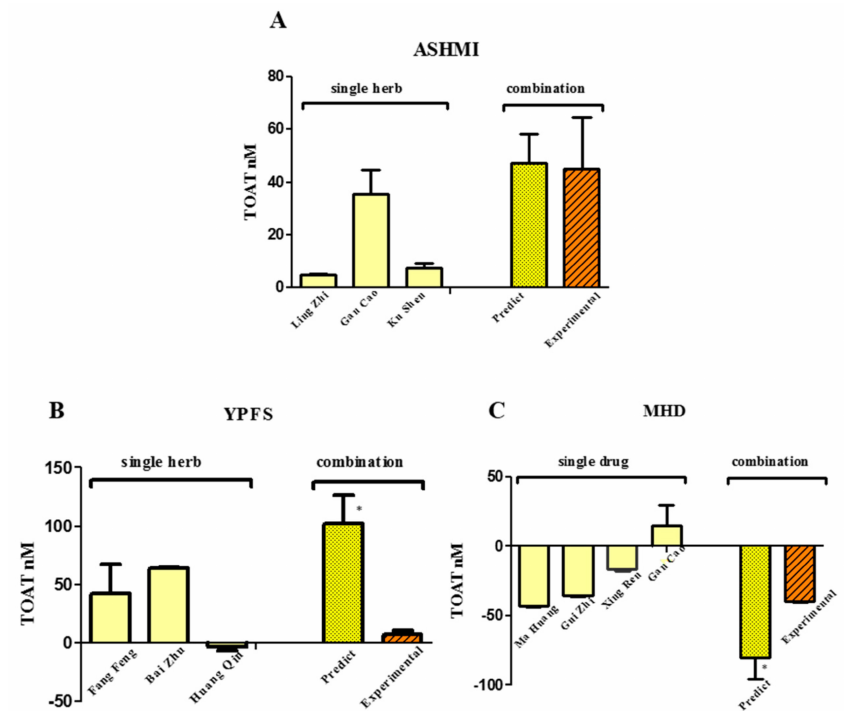
Figure 4. The TOAT of three different TCM formulas, and the TOAT of herbs used in the formulas. ( A ) Ma Huang Decotion (MHD); ( B ) Antiasthma Simplified Herbal Medicine intervention (ASHMI); ( C ) Yu Ping Feng San (YPFS). The predicted TOAT was calculated by summing the TOATs of the herbs. Predicted TOAT significantly different from the experimental TOAT (* p < 0.05).